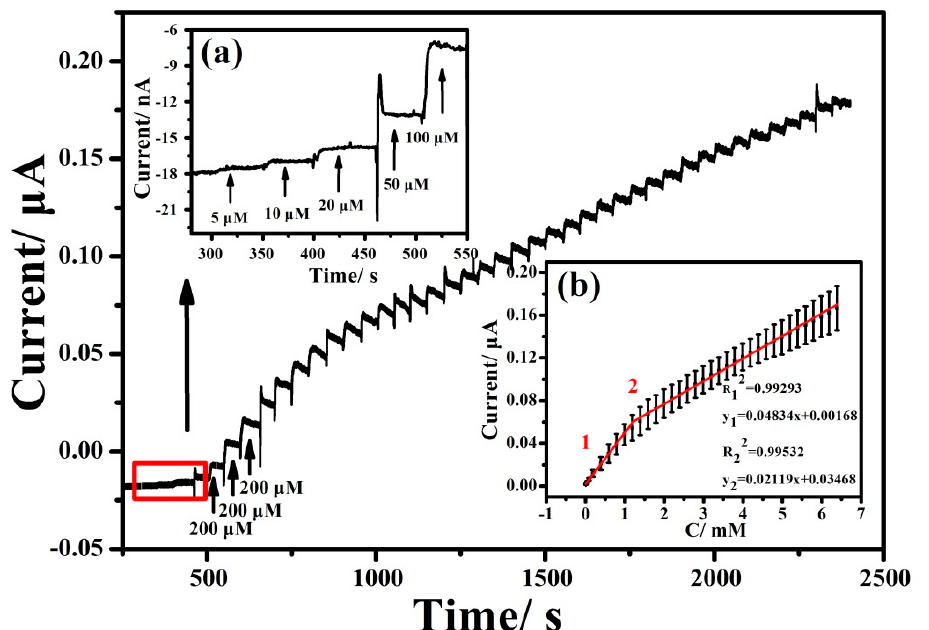
Figure 10. Amperometric responses of the PCs/CPE to various concentrations of GSH in 0.1 M PBS (pH = 4.0) at 0.25 V. (Inset: ( a ) the amplified response curve, ( b ) the calibration curve for the different concentrations of GSH).